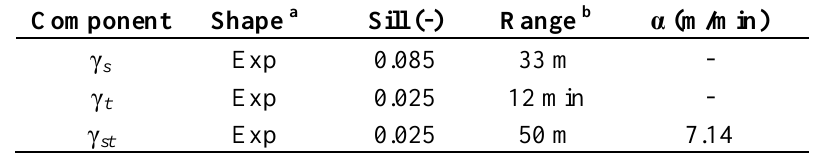
Table 2. Semivariance structure used for predicting residuals for the dynamic